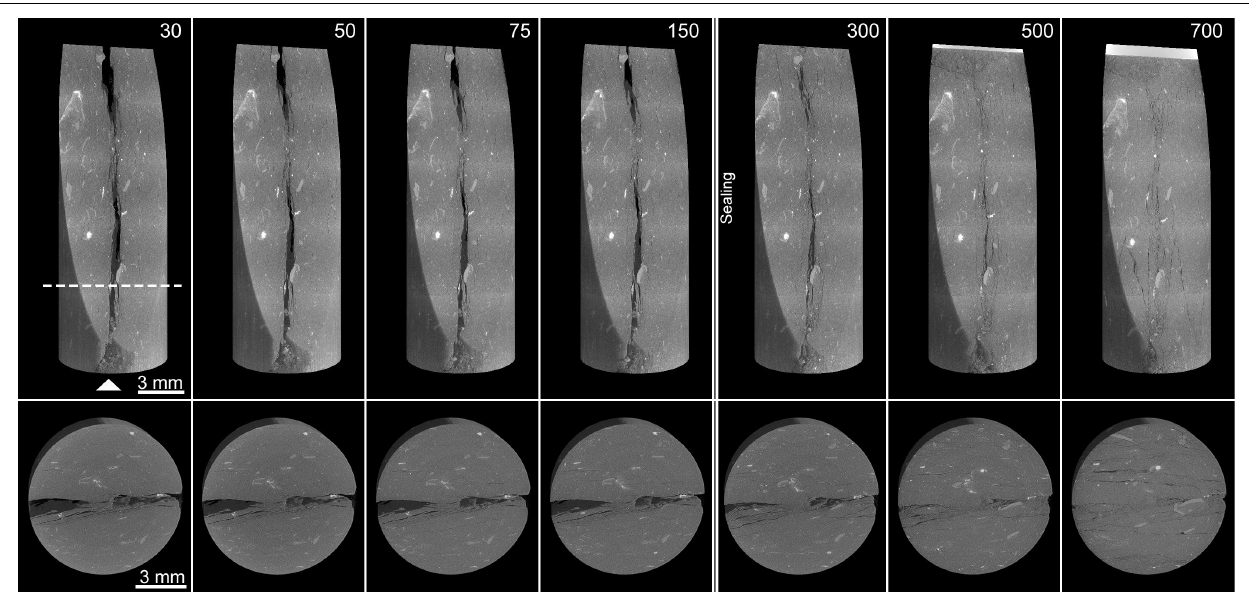
FIGURE 1 | Volume rendering of the sample during the flow experiment, while increasing the confining pressure (volumes in figure are labeled with differential pressure values, in psi). Inlet at the bottom (see arrow). On the top row a subvertical section of the sample is shown. The bottom row displays a slice of sample (at the dashed line) looking from the inlet direction.